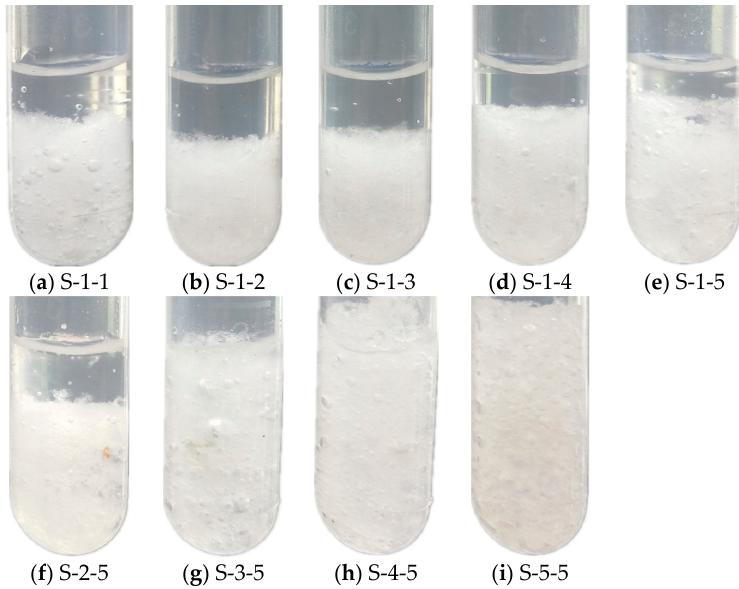
Figure 4. Photographs of the Na 2 SO 4 ·10H 2 O–5 wt.% KCl eutectics containing varying contents of PAM and STD: ( a – e ) S-1-1–S-1-5; ( f – i ) S-2-5–S-5-5.